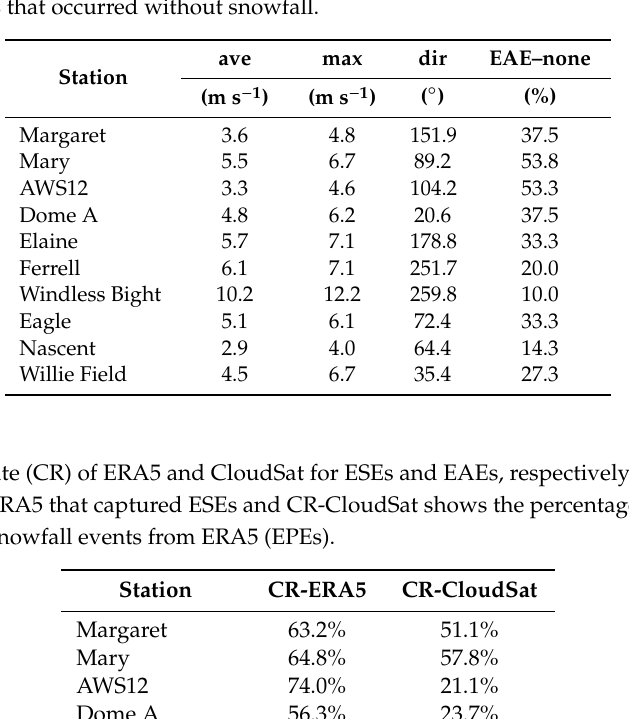
Table 4. Average and maximum wind speeds (m s − 1 ) and wind direction ( ◦ ) when extreme snow accumulation events (EAEs) occurred without snowfall. The column “EAE–none” (%) shows the percentage of EAEs that occurred without snowfall.